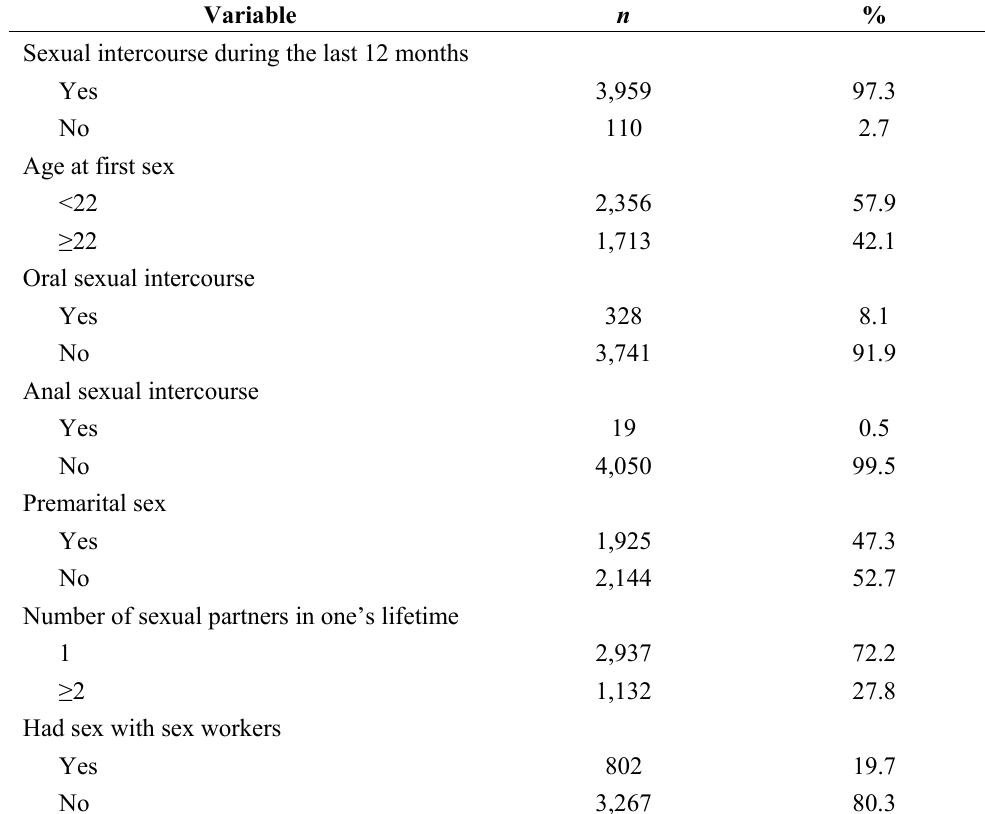
Table 3. Sexual behavior among migrants ( n =